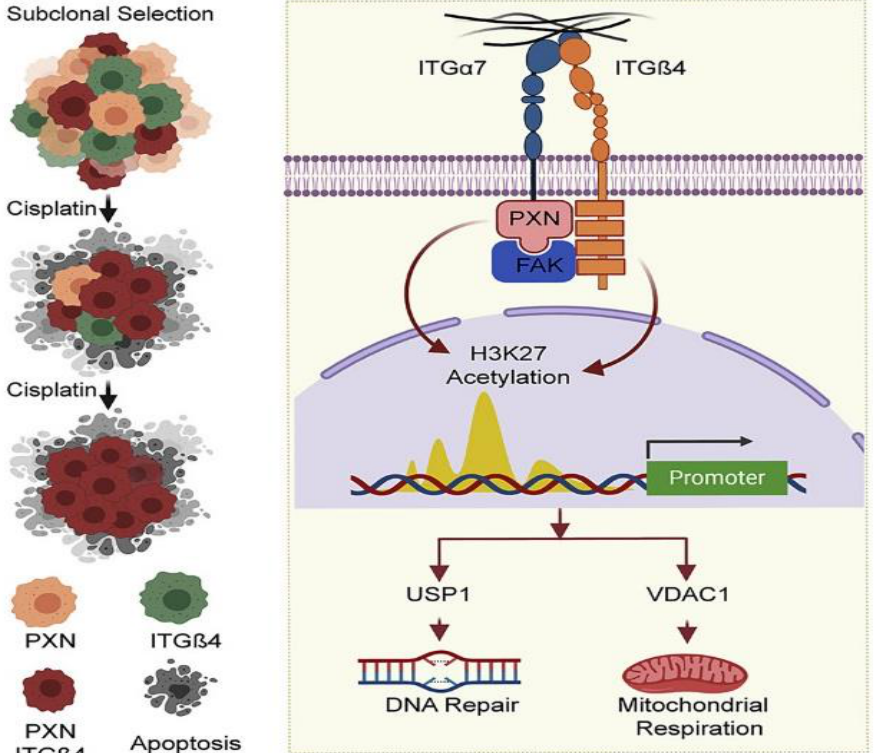
Figure 3. Schematic depicting the interaction between ITGB4 and PXN regulating downstream proteins USP1 and VDAC1 at the transcriptional level to coordinate cisplatin resistance; taken from Reprinted/adapted with permission from Ref. [51].